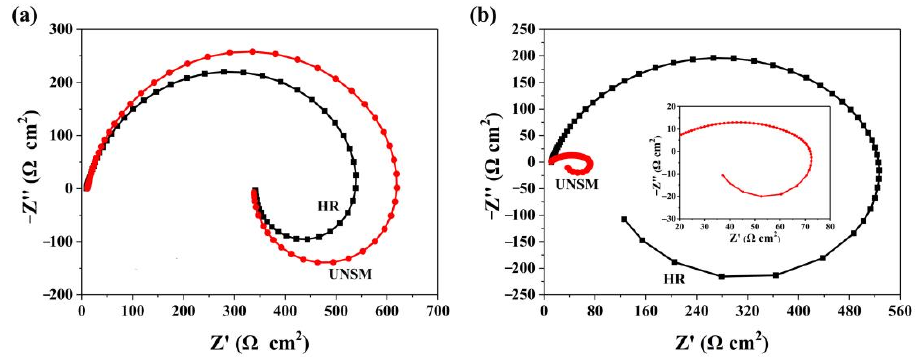
Table 2. EIS parameters obtained from the fitted equivalent circuit.